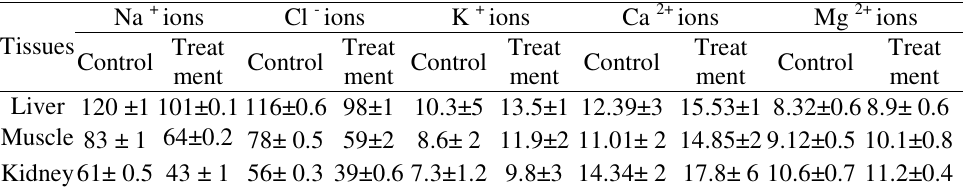
Table 1 . The concentration of Na + , Cl - , K + , Ca 2+ and Mg 2+ ions in various tissues of the fish Mastacembelus armatus exposed to sub lethal concentration of textile dye solution in meq kg -1 . Na + ions Cl - ions K + ions Ca 2+ ions Mg 2+ ions Tissues Treat Treat Treat Treat Treat Control Control Control Control Control ment ment ment ment